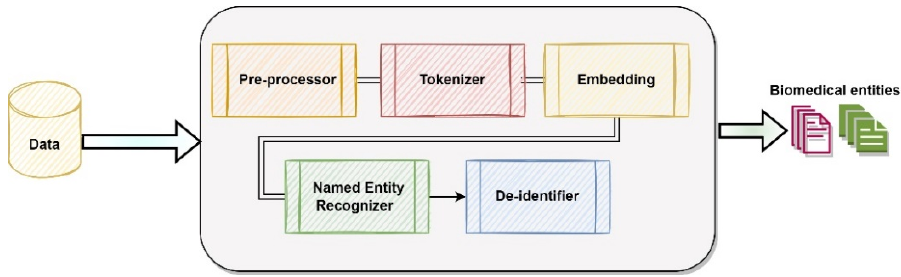
Figure 1. Biomedical Pipeline.